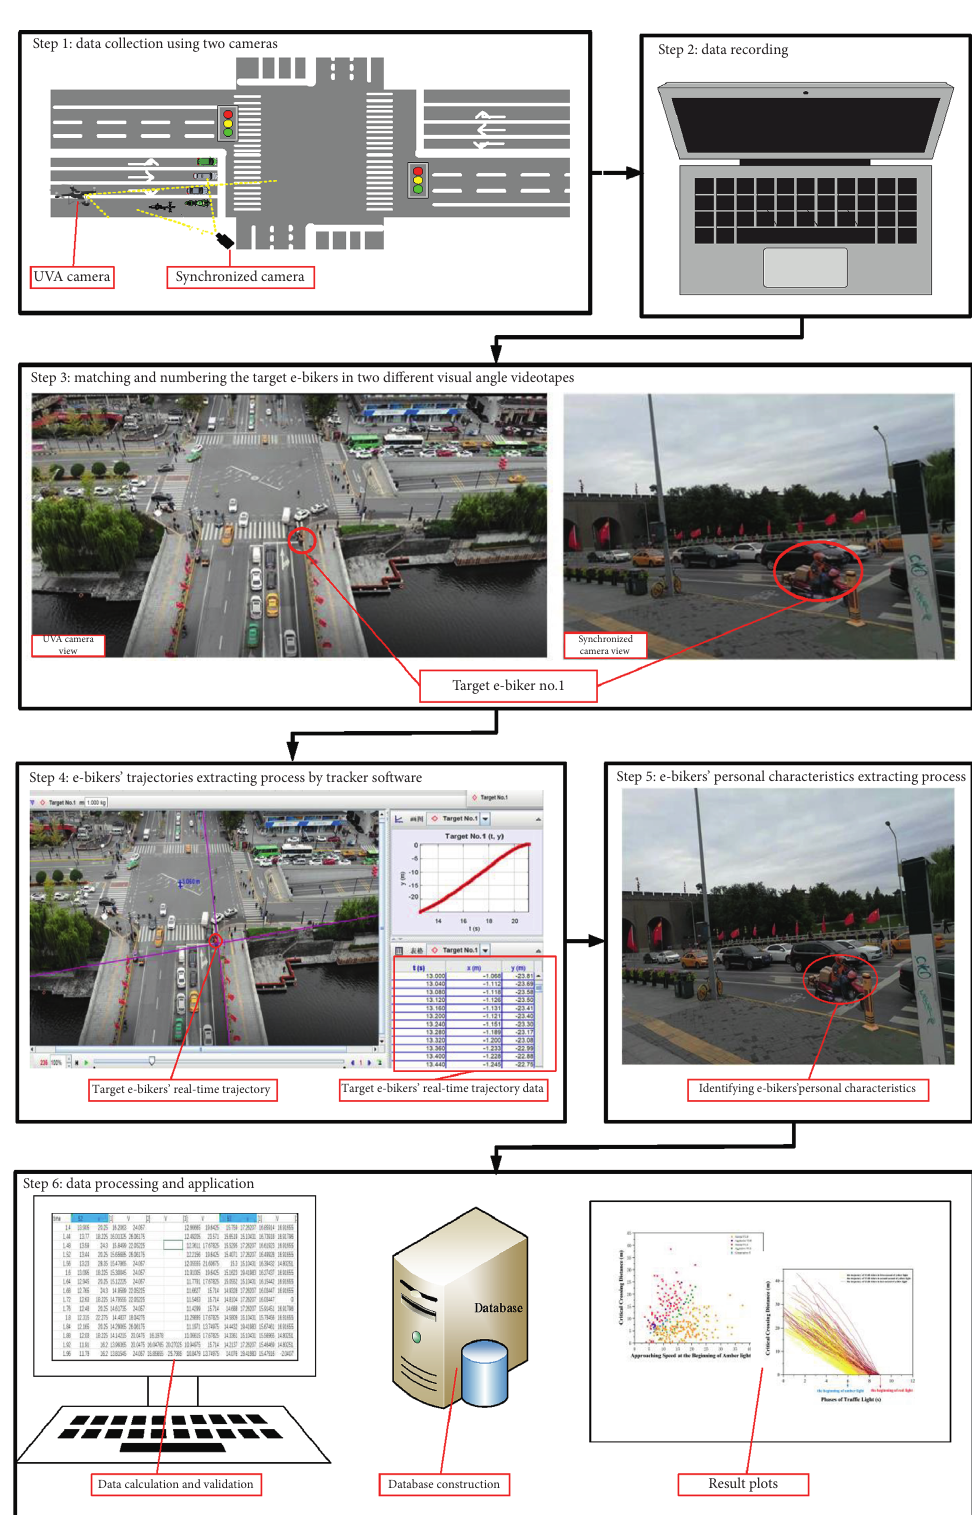
Figure 2: Data processing